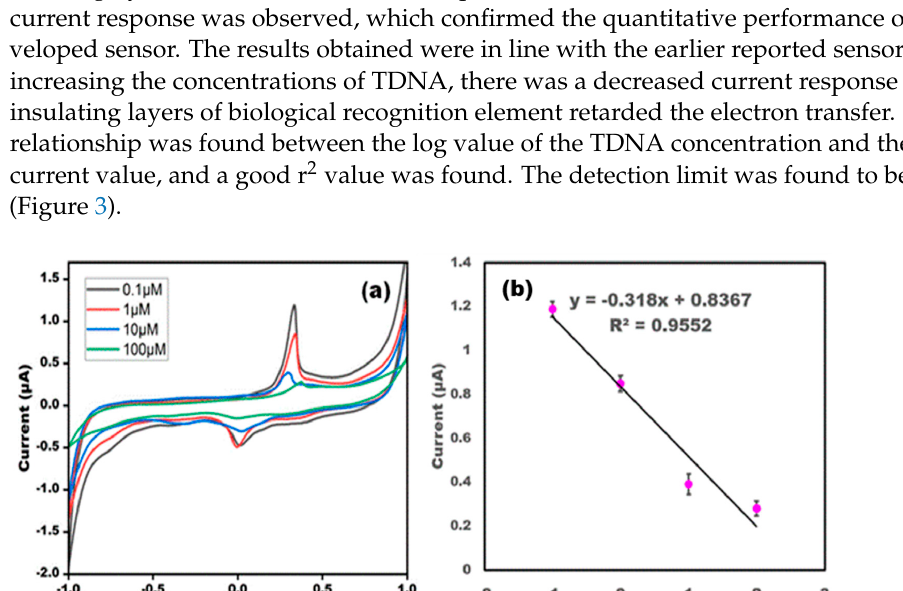
Figure 2. Cyclic voltammograms of 10 mM methylene blue in 0.1MKCl at bare PBGS, AgNPs/PBGS, DNA probe/AgNPs/PBGS and TDNA/PDNA/AgNPs/PBGS at 50 mV s − 1 in the potential range from − 1 V to +1 V.